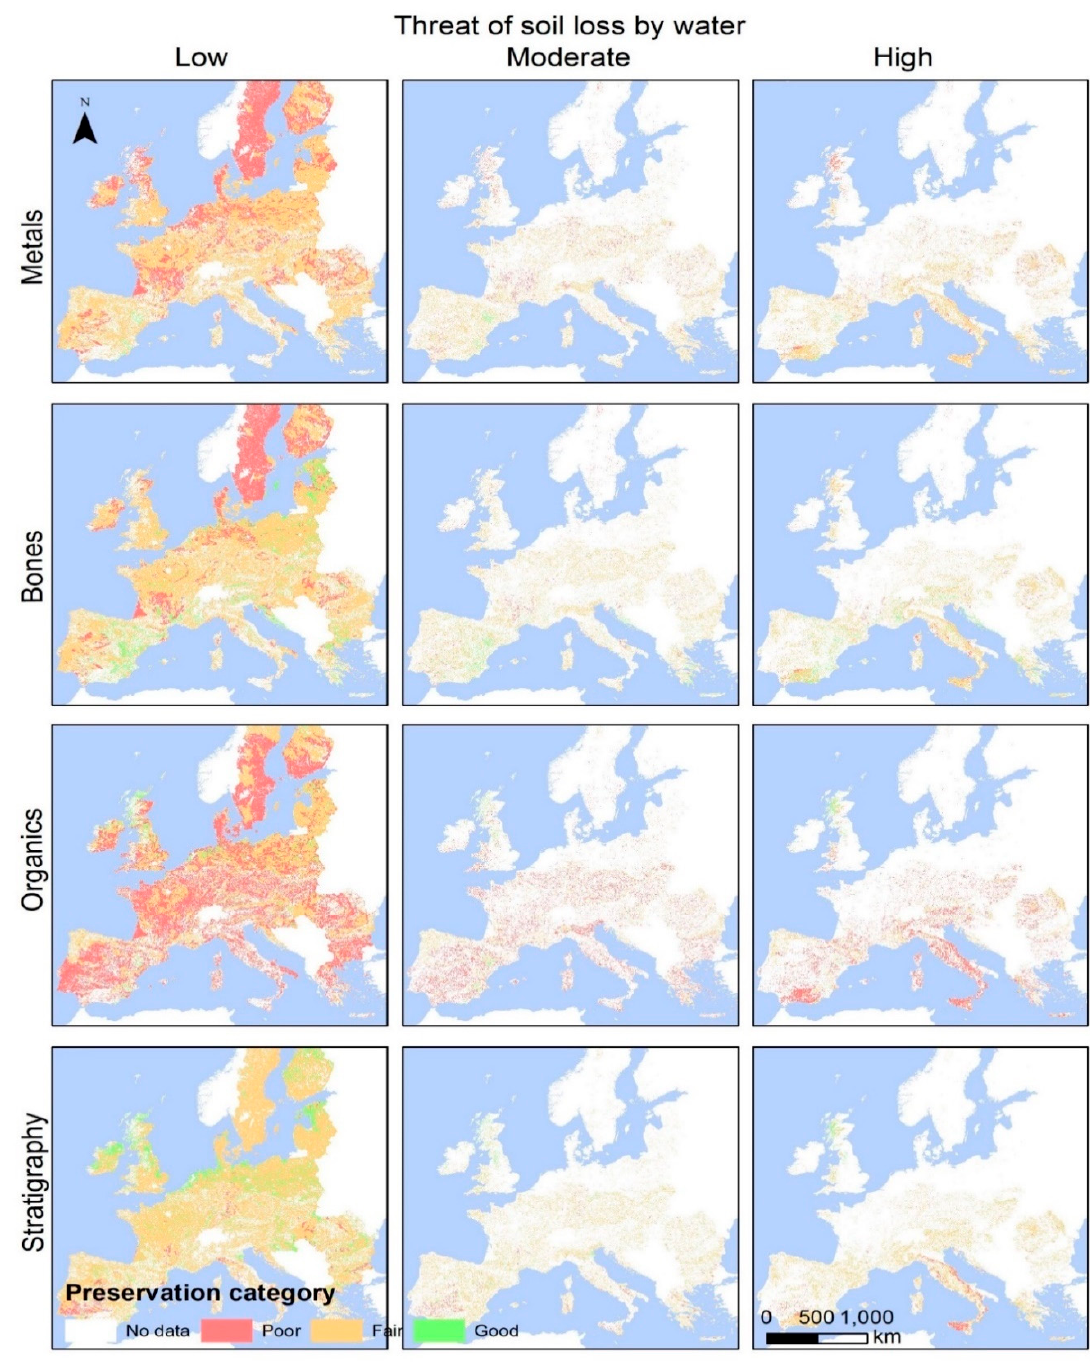
Figure 5. Maps indicating the level of threat (low, moderate, and high) based on soil loss provoked by water activity (soil erosion) for each of the four different subsurface materials (metals, bones, organics, and stratigraphy evidence): The preservation state is also indicated (red for poor, yellow for fair, and green for good).